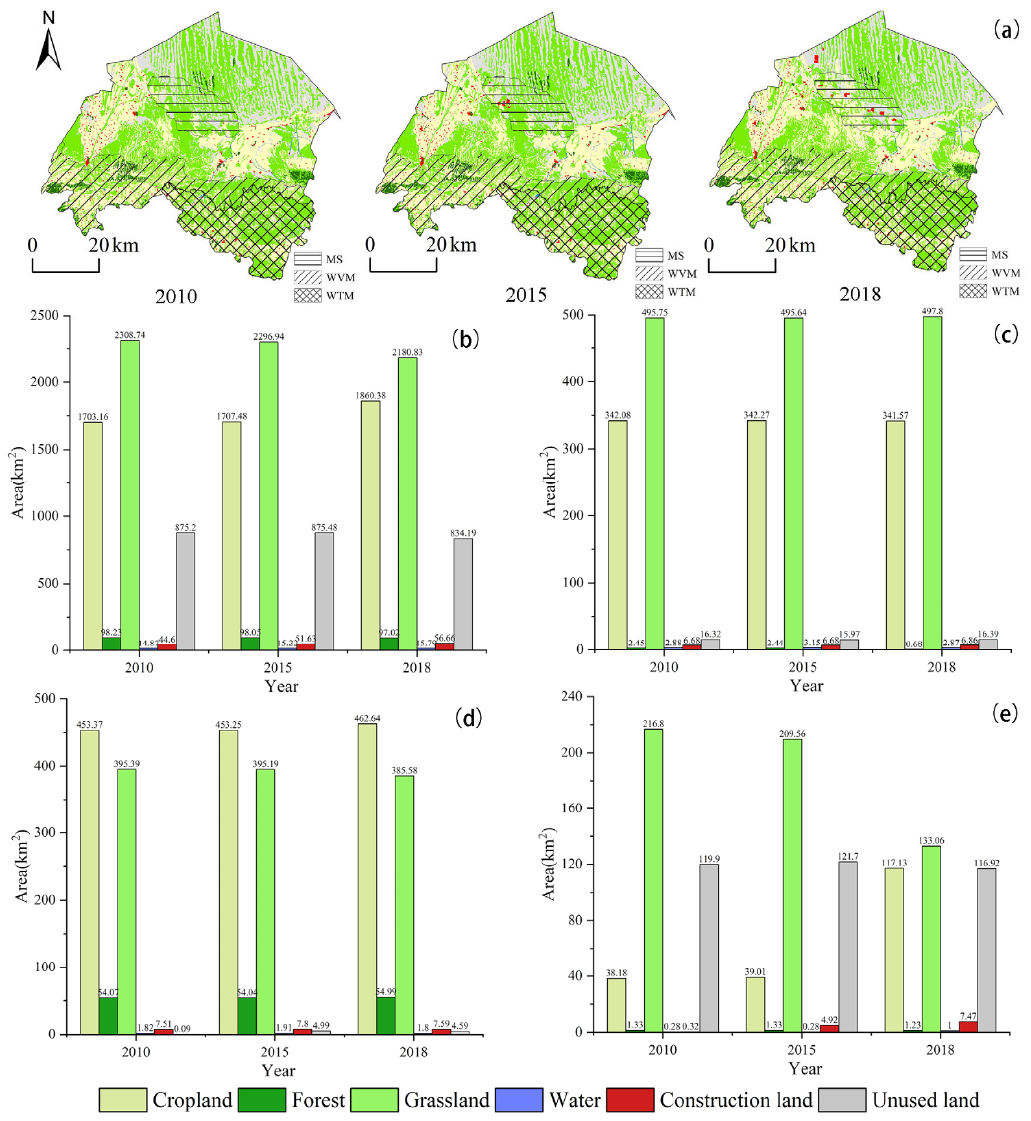
Figure 5. ( a ) Spatial distribution of land use: area of land use types, 2010–2018; ( b ) Gulang; ( c ) WTM; ( d ) WVM; ( e ) MS. Table 2. Changes in land use dynamic degree,